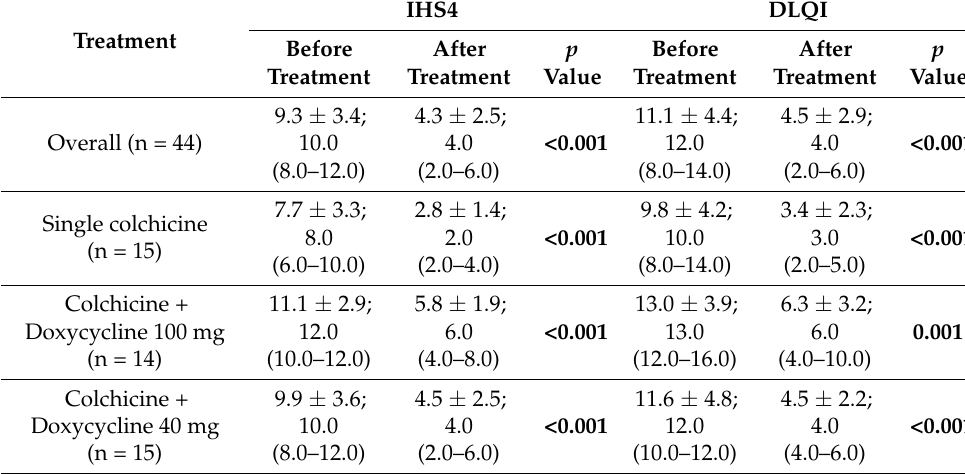
Table 2. Comparison of scores before and after the colchicine treatment regimes.